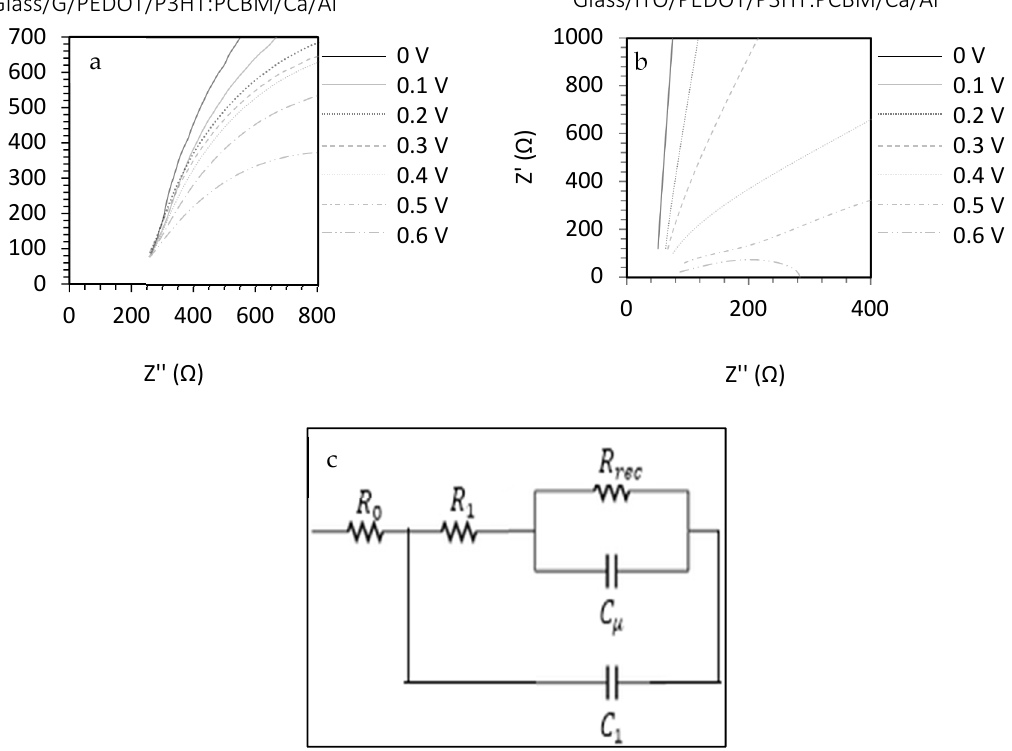
Figure 6. Nyquist plots of OPV devices is based on ( a ) graphene and ( b ) ITO as a transparent electrode, ( c ) the equivalent AC circuit of OPV.